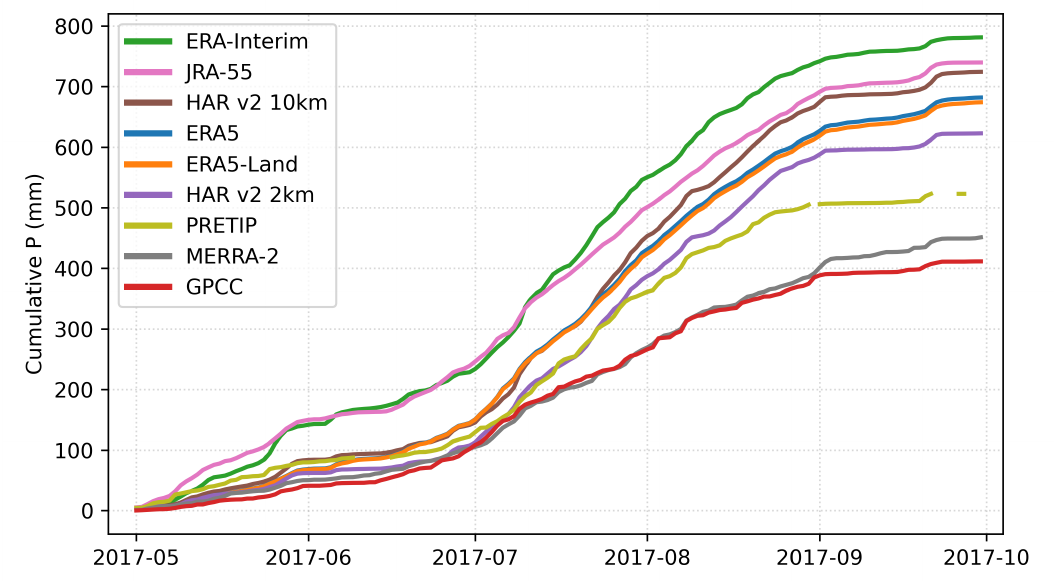
Figure 3. Spatial mean cumulative sum of precipitation throughout the study